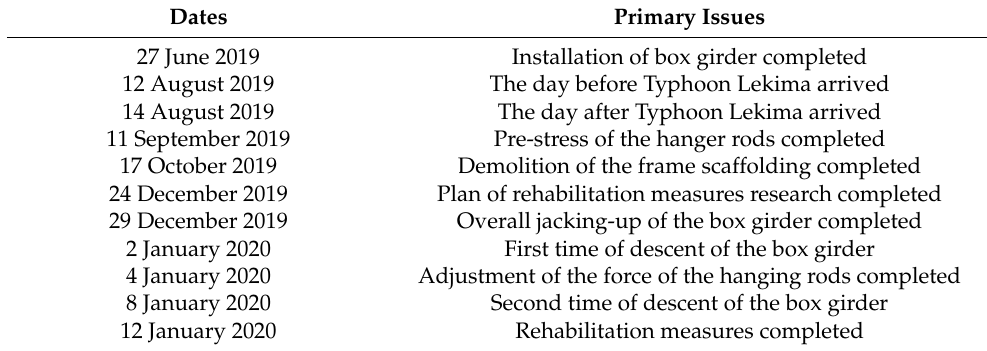
Table 3. Primary issue dates before and after the rehabilitation